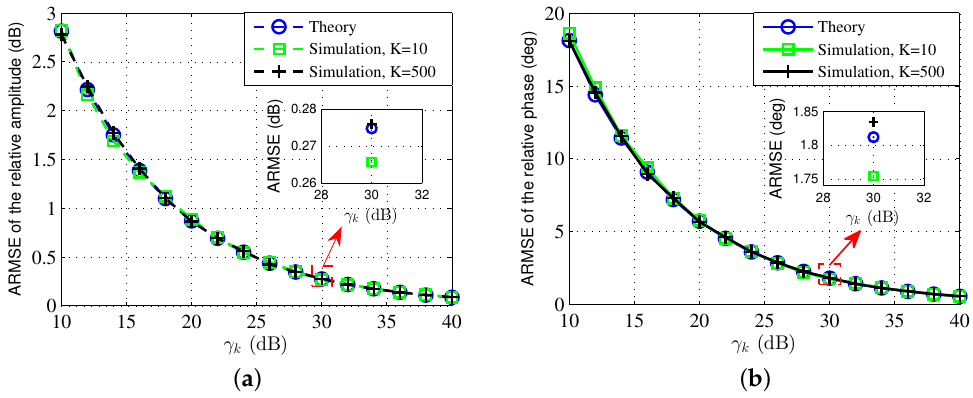
Figure 6. Theoretical and simulation calibration accuracy. ( a ) ARMSE of the relative amplitude. ( b ) ARMSE of the relative